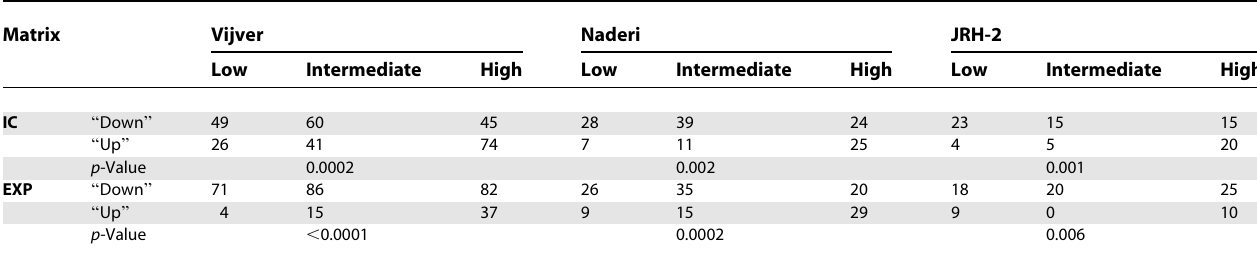
Table 3. Association of Epithelial–Mesenthymal Transition with Grade